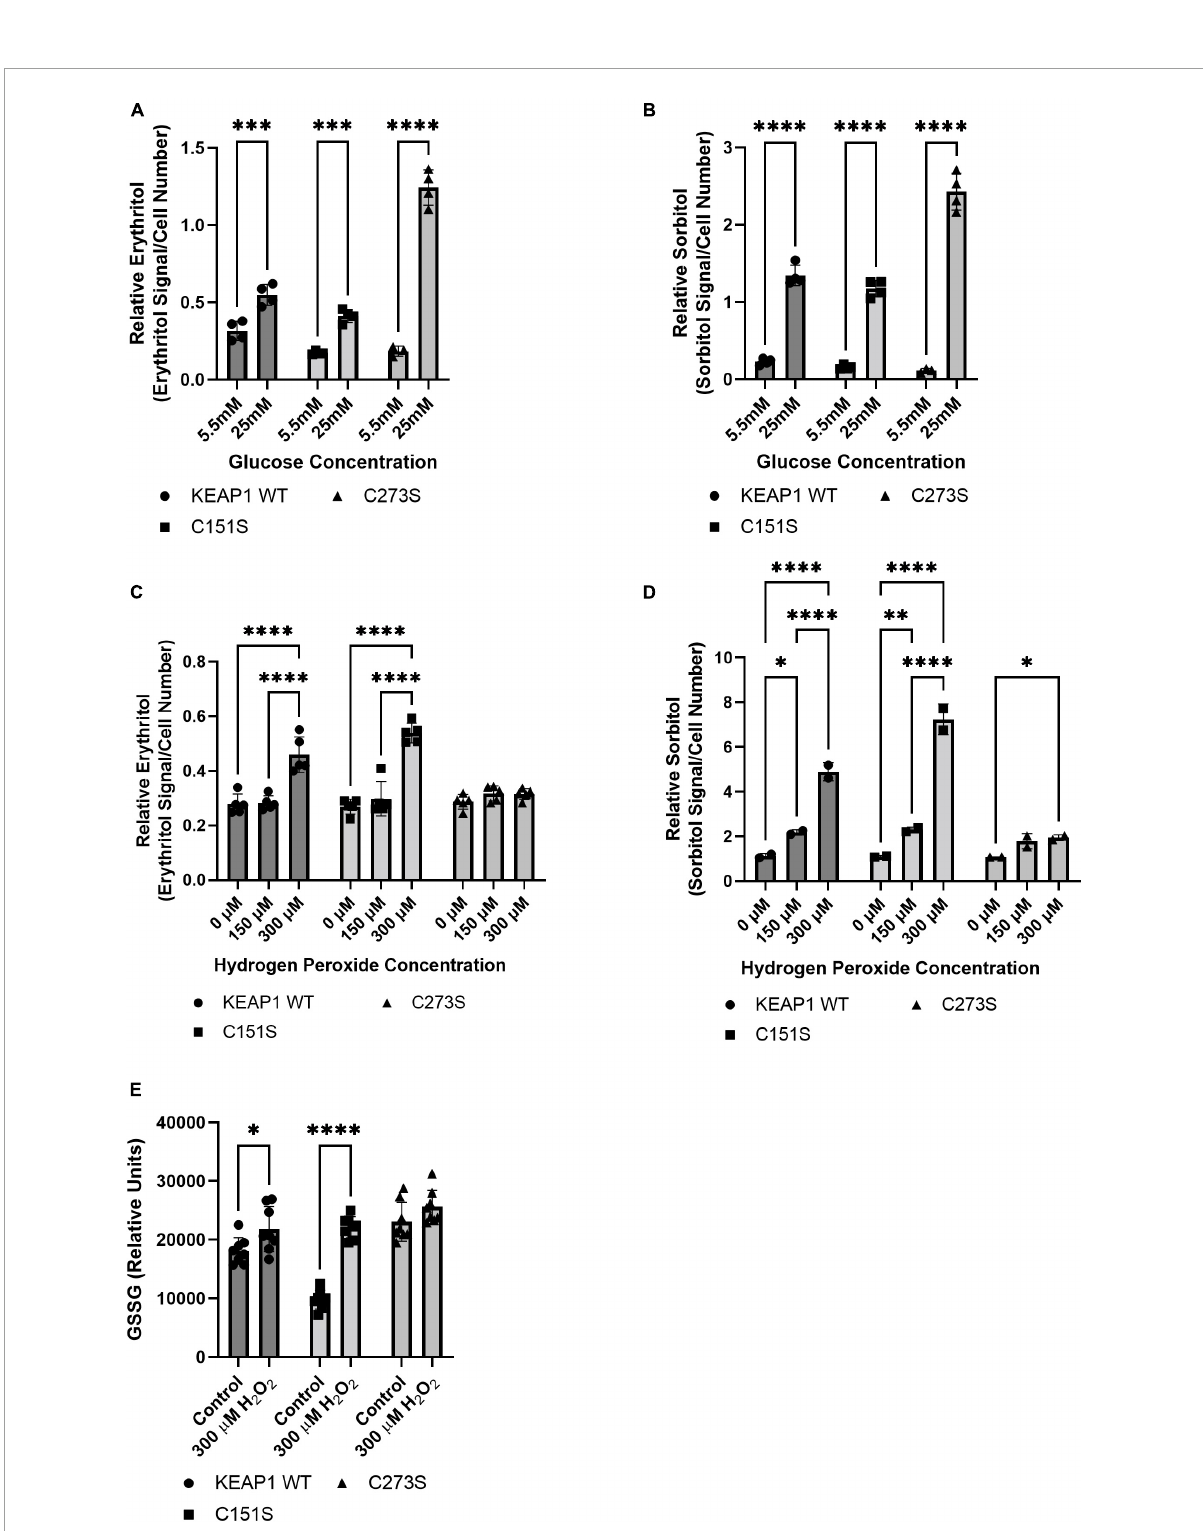
FIGURE9 KEAP1 variants modulate response to high glucose and oxidative stress. Intracellular erythritol (A) and sorbitol (B) in KEAP1 variant cells following 48 h treatment with 5.5 mM or 25 mM glucose ( n = 4). Erythritol (C) and sorbitol (D) following exposure to 0–300 µ M hydrogen peroxide for 5 h ( n = 2–5). (E) Oxidized glutathione following 5 h treatment with hydrogen peroxide. Erythritol is normalized to internal standard and cell number. Data is presented as mean ± SD and analyzed by two-way ANOVA followed by Sidak’s (A,B,E) and Tukey’s (C,D) multiple comparisons test. ∗ p < 0.05, ∗∗ p < 0.01, ∗∗∗ p < 0.001, ∗∗∗∗ p < 0.0001. WT-KEAP1 cells stably overexpress KEAP1. C273S cells have impaired ability of KEAP1 to repress NRF2, resulting in constitutively active NRF2. C151S cells exhibit constitutive repression of NRF2. GSSG, oxidized glutathione; H 2 O 2 , hydrogen